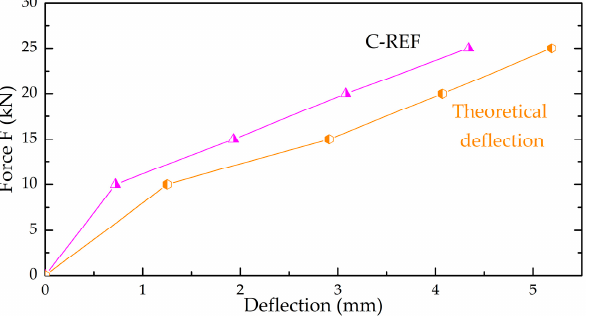
Figure 13. A graph showing a comparative analysis of experimental results (C-REF) and numerical deflection.